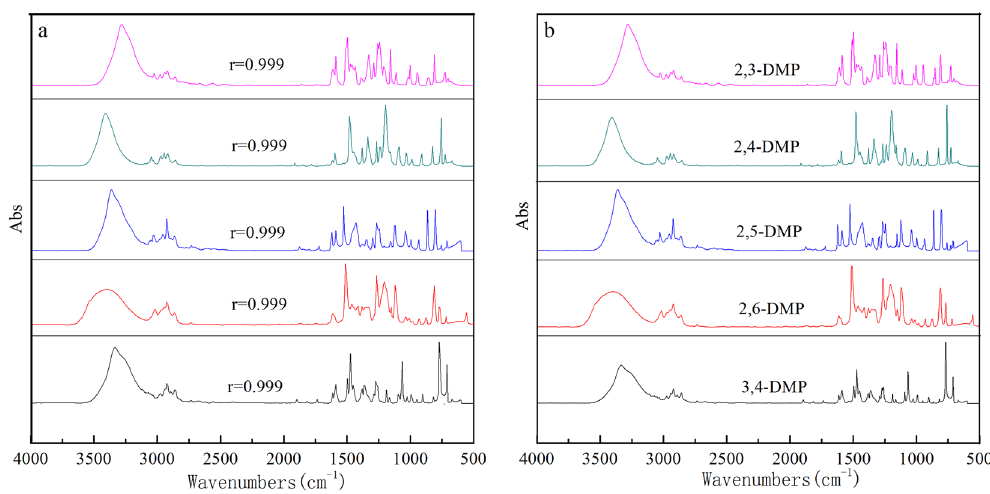
Figure 6. IR spectra of DMP isomers (2,3-DMP, 2,4-DMP, 2,5-DMP, 2,6-DMP, 3,4-DMP): ( a ) IR spectra obtained; ( b ) IR standard